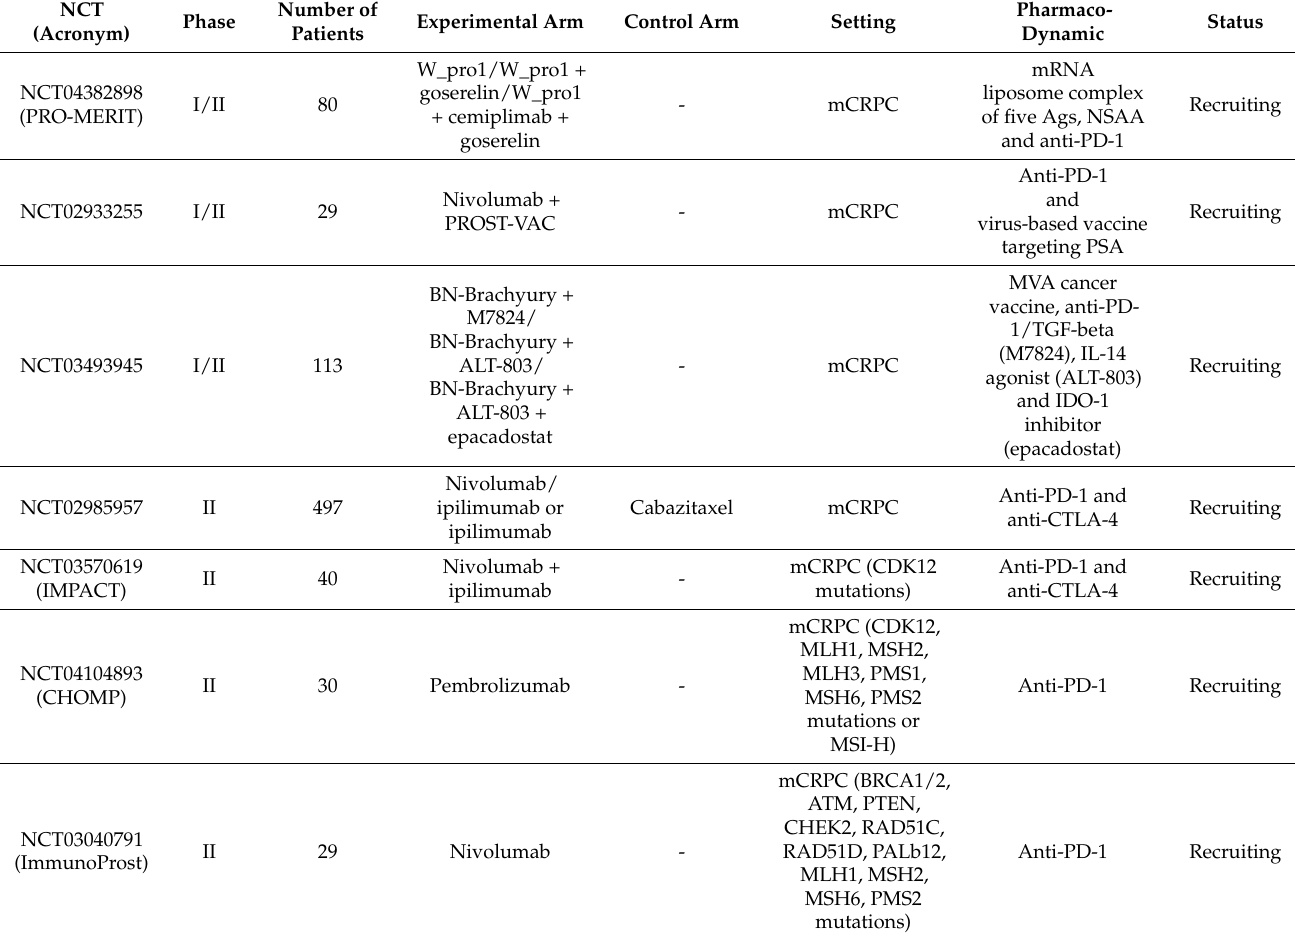
Table 2. An overview of the ongoing clinical trials assessing immune checkpoint inhibitors alone or in combination with other immunotherapeutic agents in advanced prostate